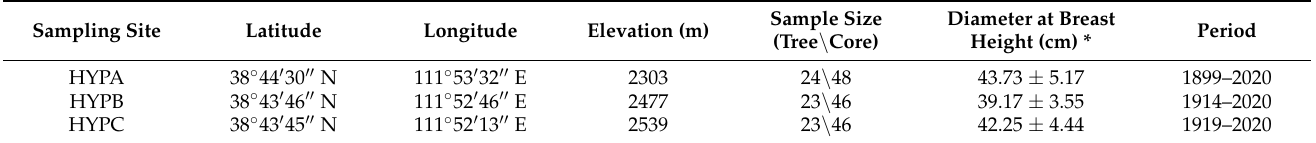
Table 1. Information on the three tree-ring sampling points located at different elevations on Guancen Mountain.